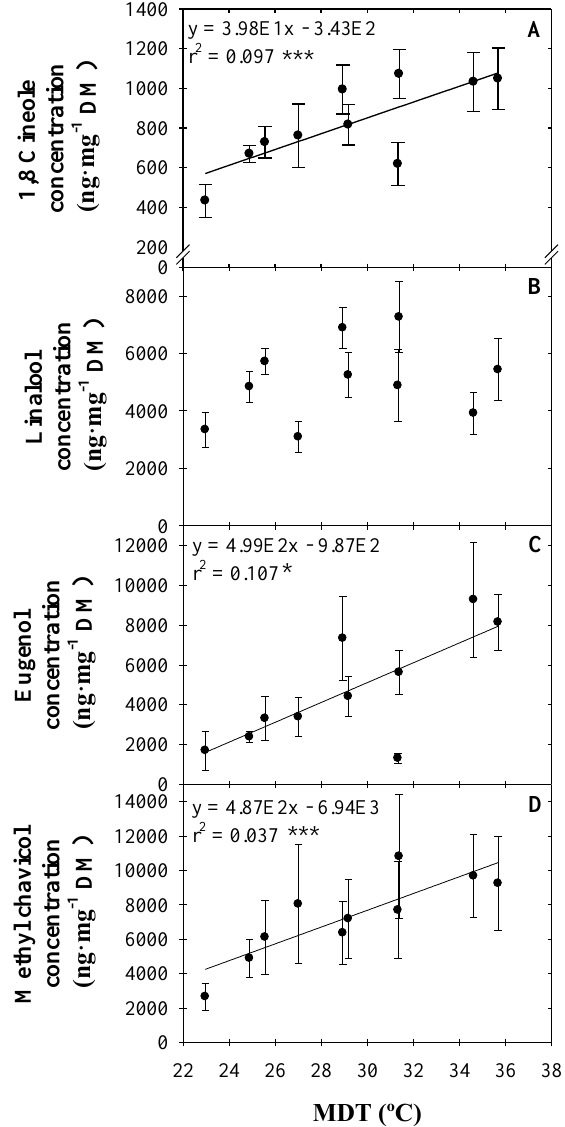
Figure 1. Volatile Concentrations influenced by MDT. Concentrations [ng · mg − 1 dry mass (DM)] of 1,8 cineole ( A ), linalool ( B ), eugenol ( C ), and methyl chavicol ( D ) of sweet basil ( Ocimum basilicum ‘Nufar’) grown at mean daily temperatures (MDT) from 23 to 36 ◦ C for three weeks. Symbols represent the mean of 15 plants ± se. Lines represent linear regression. * and *** indicate significant at p ≤ 0.05 or 0.001, respectively.